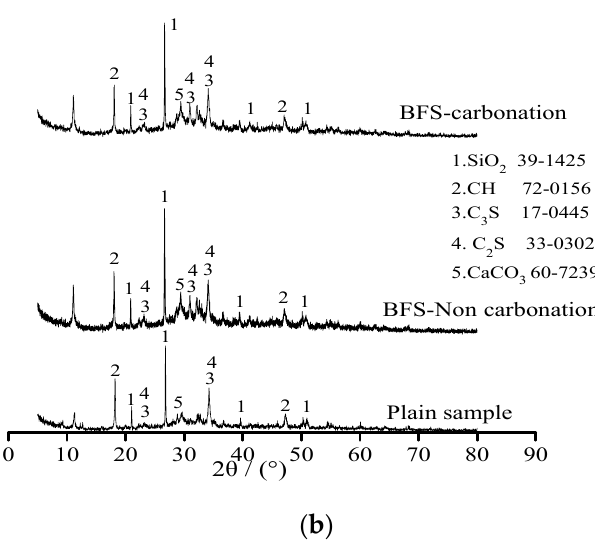
Figure 4. The X-ray diffraction of specimens. ( a ) Specimens with FA; ( b ) Specimens with BFS.